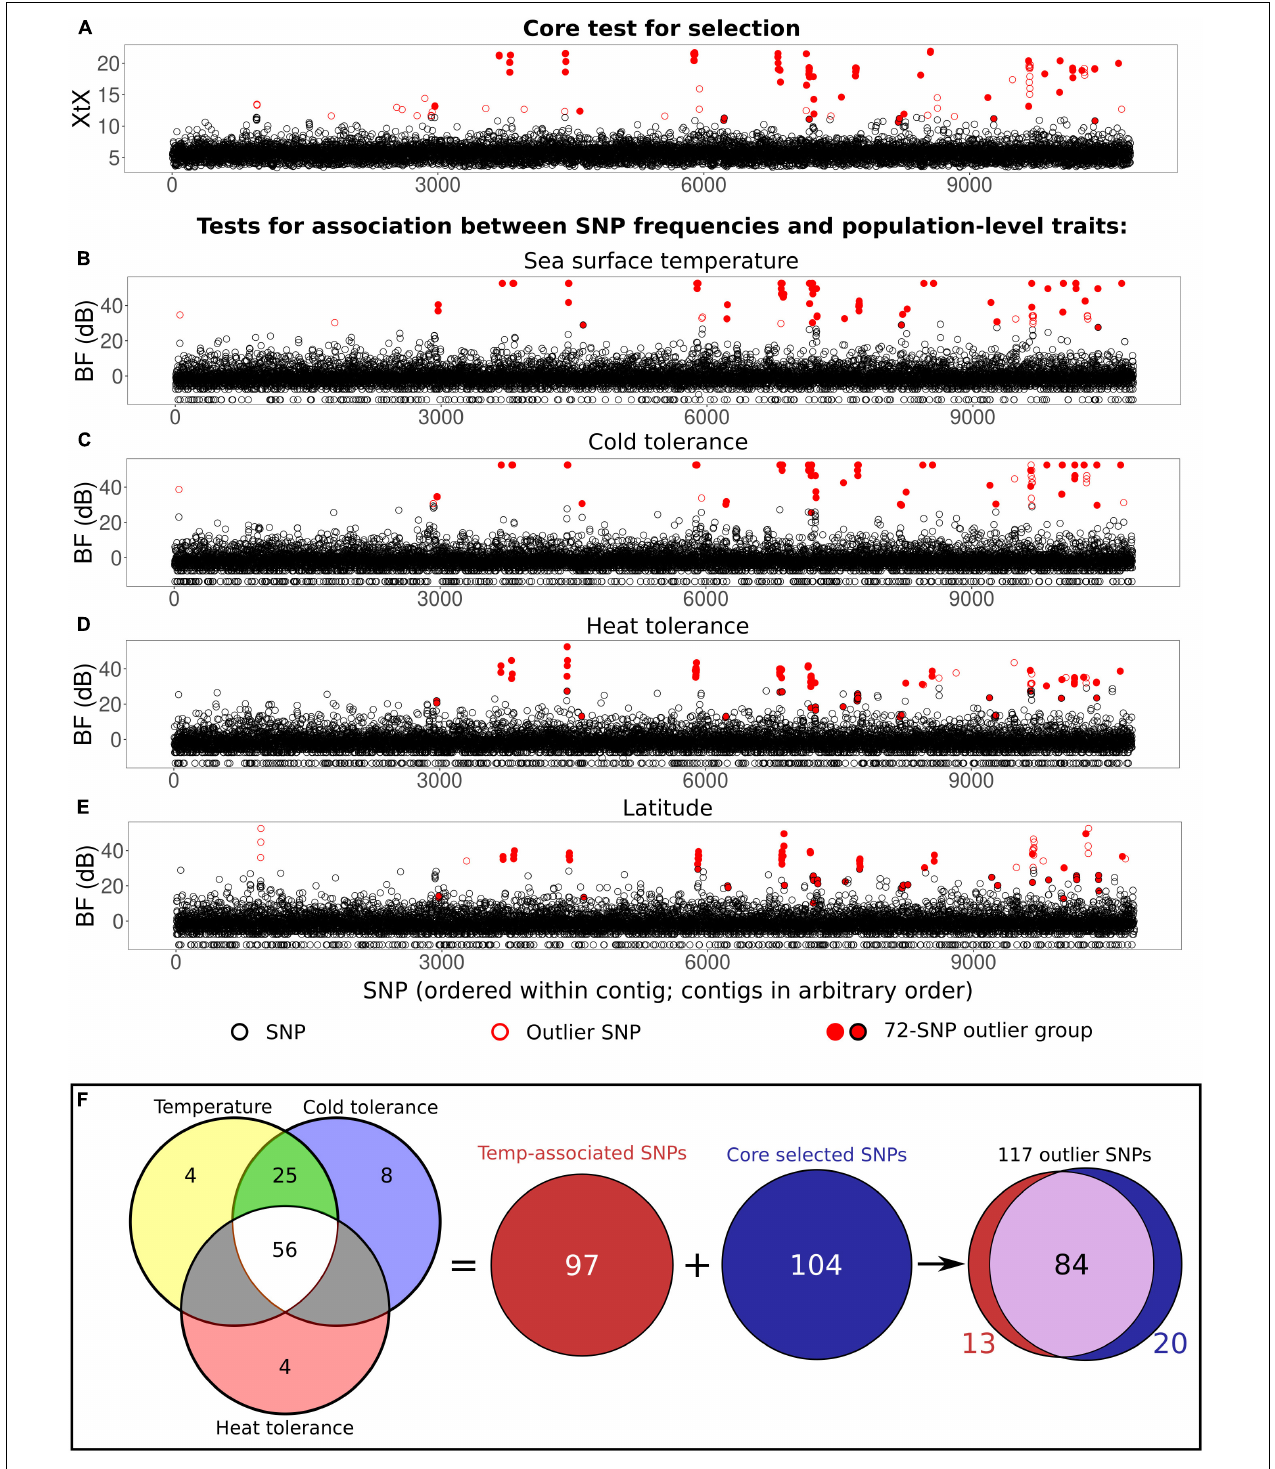
FIGURE 2 | (A–E) : SNPs identified as potentially under selection using BayPass; individual SNPs are in the same positions in all panels. SNPs outlined in red are outliers in that test; SNPs filled in red are in the 72-SNP LD cluster. SNPs are ordered within each contig; contigs are ordered arbitrarily. (A): Test for XtX frequency outliers based only on genotypes. (B–E): Tests for association between SNPs and population-level traits (temperature, heat and cold tolerance, and location latitude). (F): Overlap between SNPs identified with different tests. Left: Overlap between SNPs identified as associated with population-level traits: temperature, cold tolerance, and heat tolerance. Right: Overlap between SNPs identified as outliers in the core analysis (A) and SNPs identified as associated with at least one of the three thermal or physiological traits (B–D) .